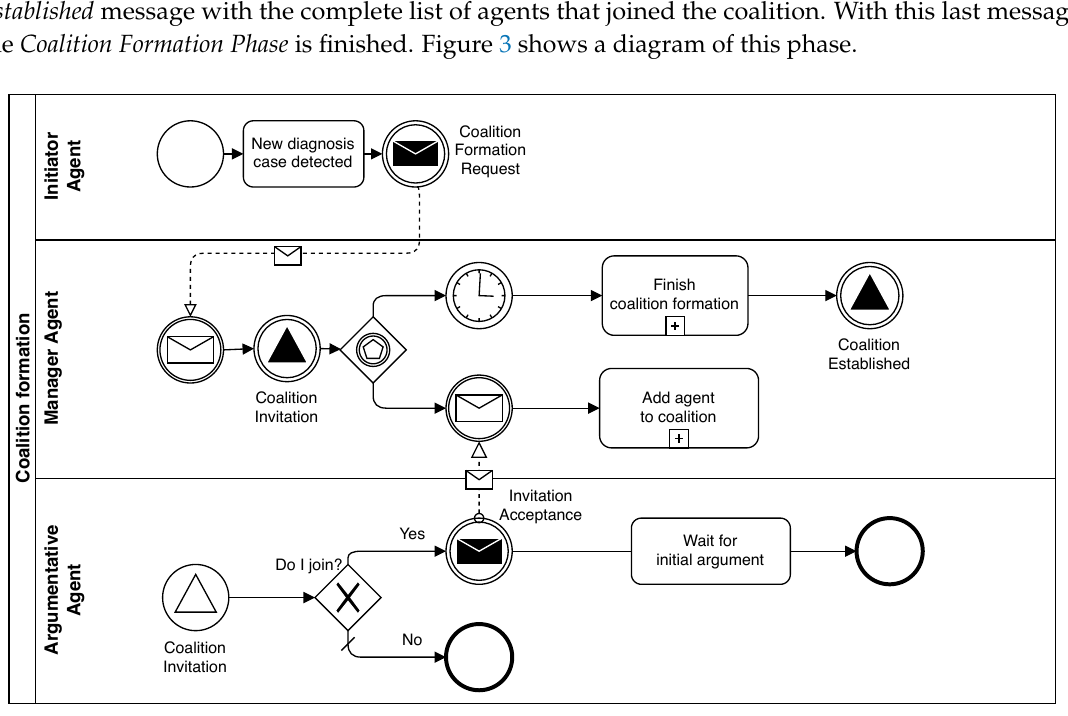
Figure 3. Coalition Formation